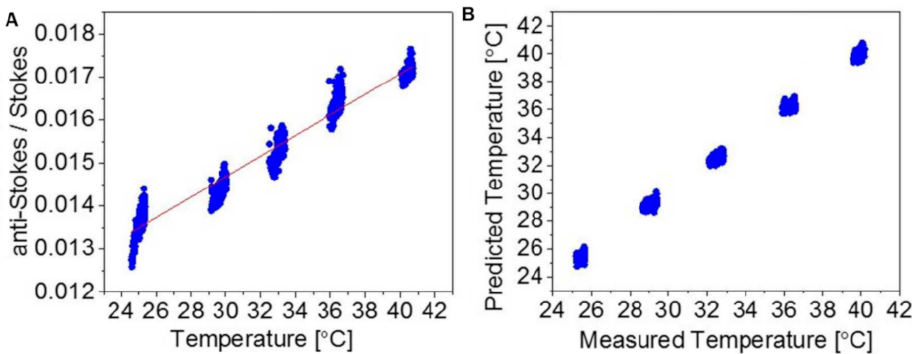
Figure 11. Model of heating AuNPs (25–42 ◦ C) buried in 10 mm porcine tissue. ( A ) The aver- age anti-Stokes/Stokes band of the thiol-based Raman reporter (~1080 cm − 1 ) at each temperature point. ( B ) Predicted temperatures vs. the measured temperature of the AuNPs. Adapted with permis- sion from [192].